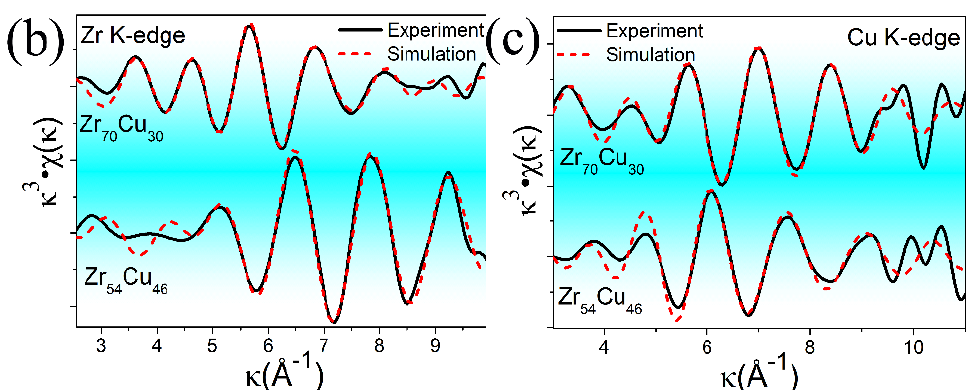
Figure 4. XRD and EXAFS experimental data as well as their corresponding simulated curves, including ( a ) S ( Q ); ( b ) Zr K-edge; and ( c ) Cu K-edge EXAFS data. The experimental and simulated data are plotted with solid and dashed lines, respectively. Both experimental and simulated Zr and Cu K-edge signals were weighted by κ 3 . To highlight the S ( Q ) difference between the experimental and the simulated data for both samples, the Q region here was shortened to about 16 Å −1 .